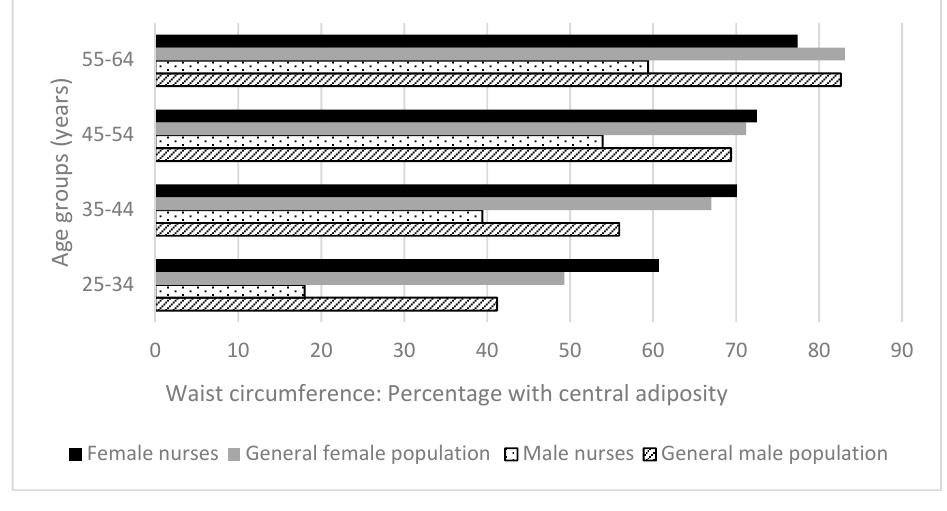
Figure 5. Health-related behaviors of nurses and midwives compared to the Australian general population 2014–2015 [25]: Waist circumference in central adiposity range.